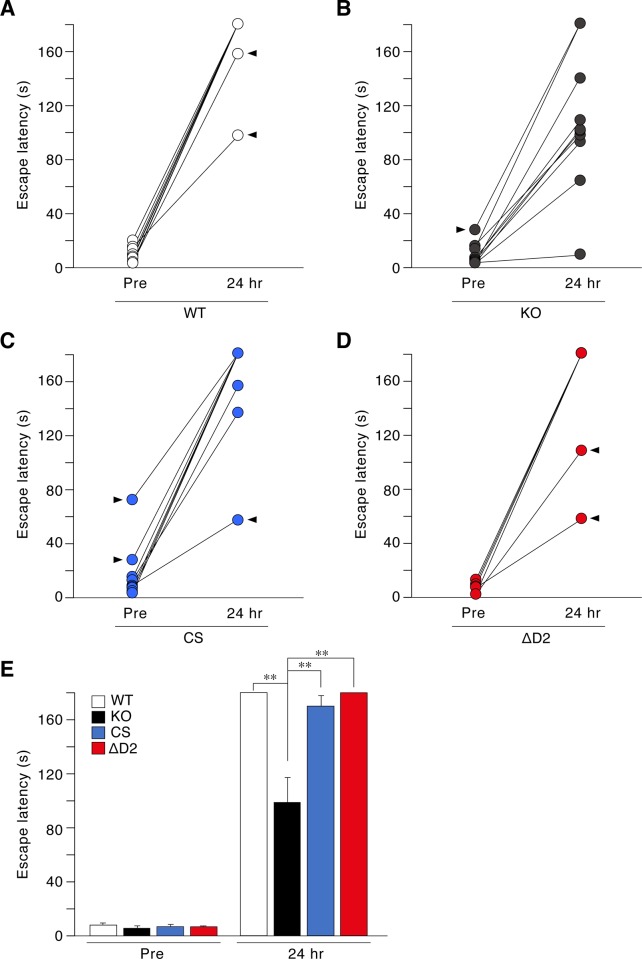
Aversive learning.(A to E) A step-through inhibitory avoidance test. Mice were placed in the light compartment, and their escape latency to enter the dark compartment was measured before receiving footshocks (Pre) and 24 hrs after footshock conditioning. Scatter plots show individual values of wild-type (A), Ptprz-KO (B), CS knock-in (C), and ΔD2 knock-in (D) mice (n = 10 animals per group), in which eight values obtained from eight mice were outliners by Grubb's test (pointed by arrowheads). After removing the data of the eight mice, the trimmed data set was shown as a bar graph with the mean and SE (E). There were significant effects of training (F(1,28) = 1053.244, P = 0.000), genotype (F(3, 28) = 17.920, P = 0.000), and interactions of between training and genotype (F(3, 28) = 18.842, P = 0.000) by two-way mixed design ANOVA. **, P < 0.01, significantly different between the indicated groups by posthoc Tukey HSD test.